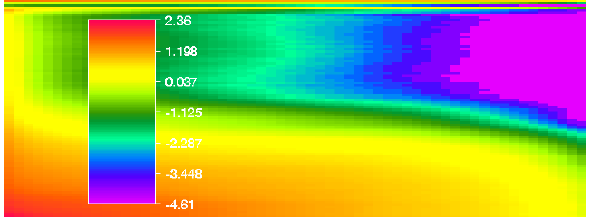
Figure 5. An example of the log(log( L ( r , h )) images with colour scale (as an inset). The L ( r ) functions are plotted horizontally as coloured bars, the (relative) elevation h increases towards the top. Width of the figure is 100 m, the height is ca. 25 m. Note the negative values for certain colours; this is the consequence of the log(log()) operation.